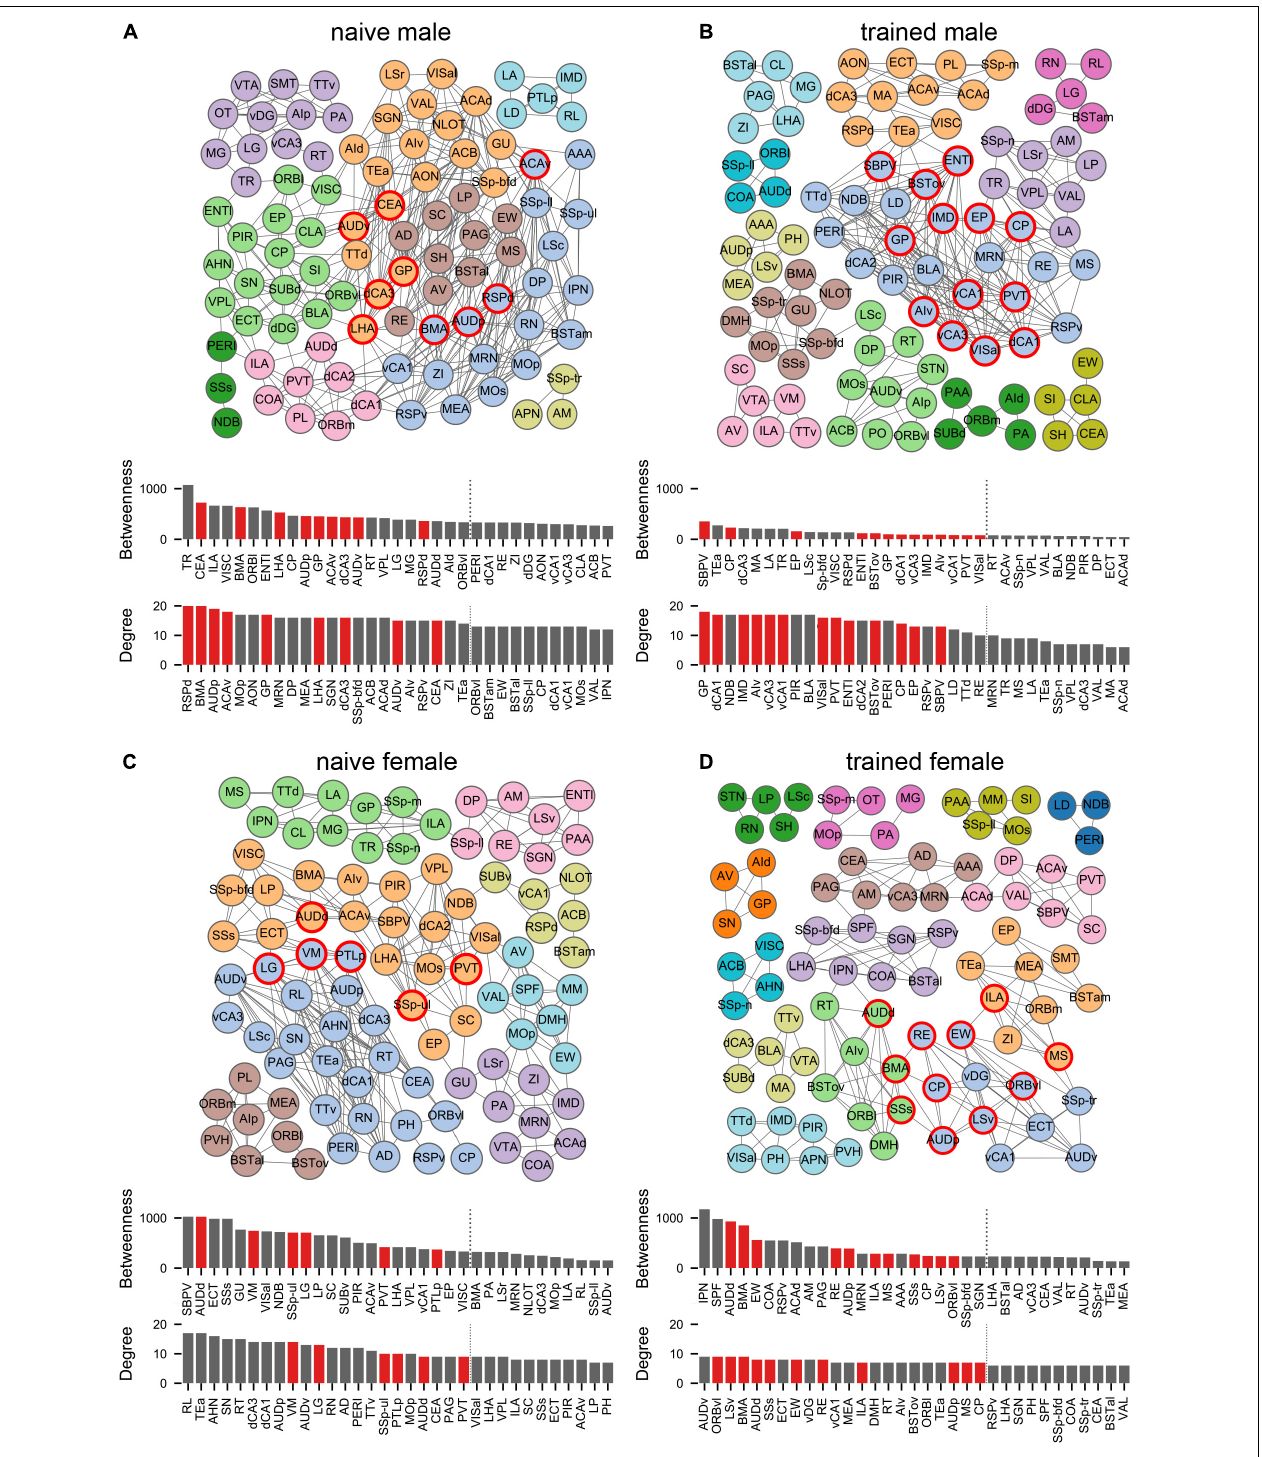
FIGURE 4 | Males and females recruit distinct network structures for cued threat conditioning. Network graphs showing brain regions (nodes) as circles and supra-threshold correlations between regions (edges) as lines for (A) naïve male, (B) trained male, (C) naïve female, and (D) trained female groups. Node colors correspond to clusters found using the Markov clustering algorithm applied to the adjacency matrix for each group, which identifies sets of nodes that are more connected with each other than with nodes outside of the cluster. Bar plots show centrality measures of degree (number of edges) and betweenness (number of shortest paths through a node). The top 30% of nodes for each measure are shown. Hubs (red) are nodes within the top 20% (indicated by the vertical dotted line) for both measures. See Supplementary Table 1 for a list of regions and their acronyms.